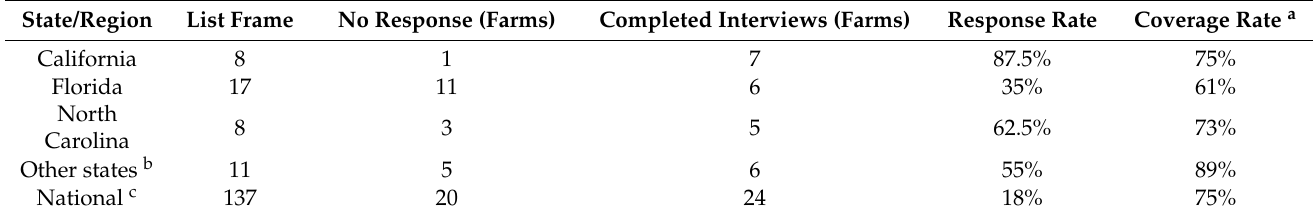
Table 1. List frame development, tilapia regulatory cost survey, 2021.